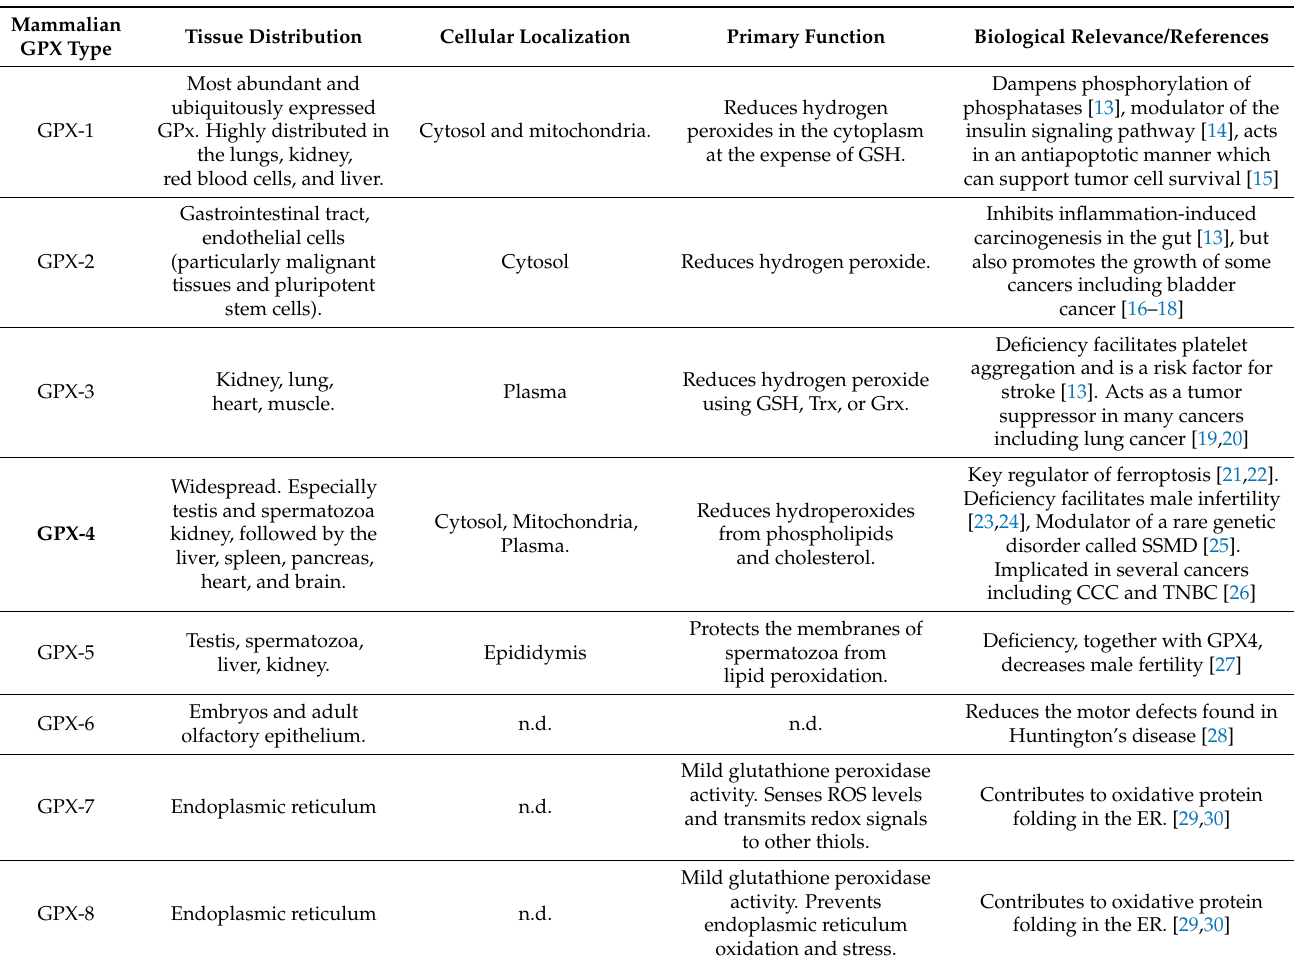
Table 1. Biochemical Features and Biological Relevance of GPX family.